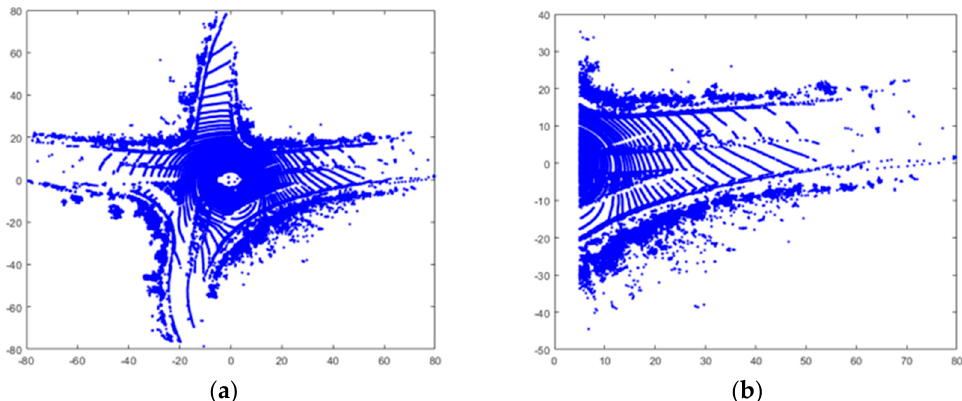
Figure 4. Example of point cloud data (PCD) from a LiDAR ( a ) PCD (Top View); ( b ) Extracted PCD (Top View).